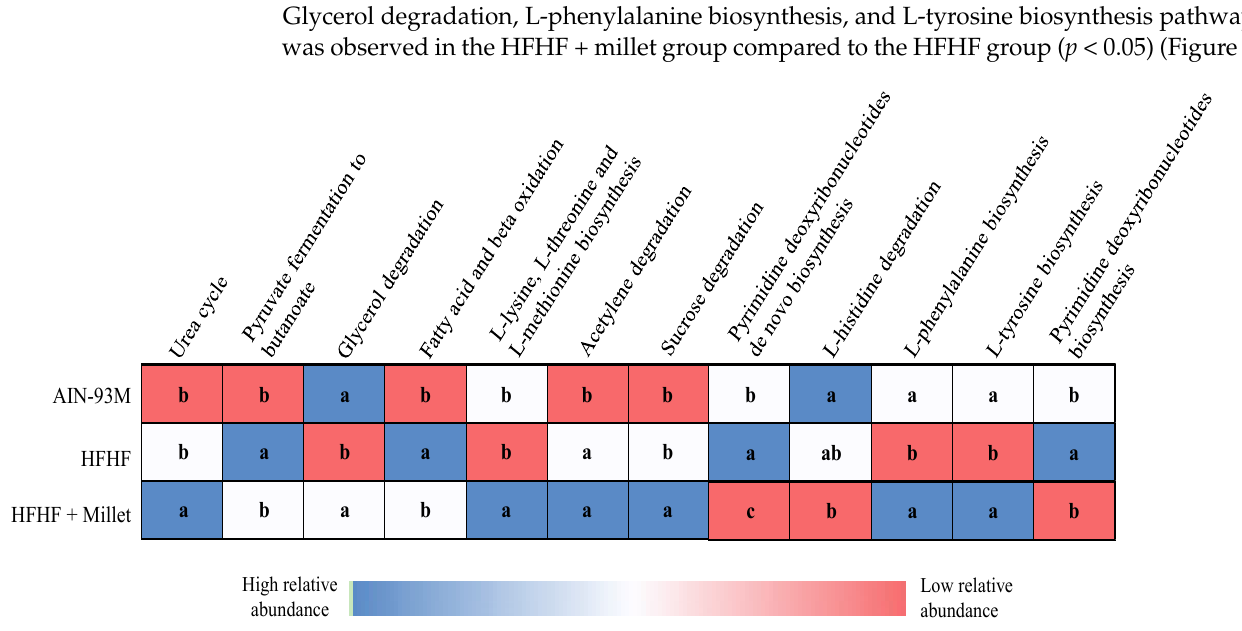
Figure 5. Relative significance of differentially enriched microbial metabolic pathways in cecal microbiota after the consumption of high-fat high-fructose diet associated with millet. Columns with different letters indicate significant differences by one-way ANOVA and post hoc of Duncan’s test ( p < 0.05). n = 10/group (AIN-93M, HFHF groups) and n = 9/group (HFHF + millet group). AIN-93M: animals fed with a standard diet; HFHF: high-fat high-fructose diet; HFHF + millet: high-fat high-fructose diet with added germinated millet flour.